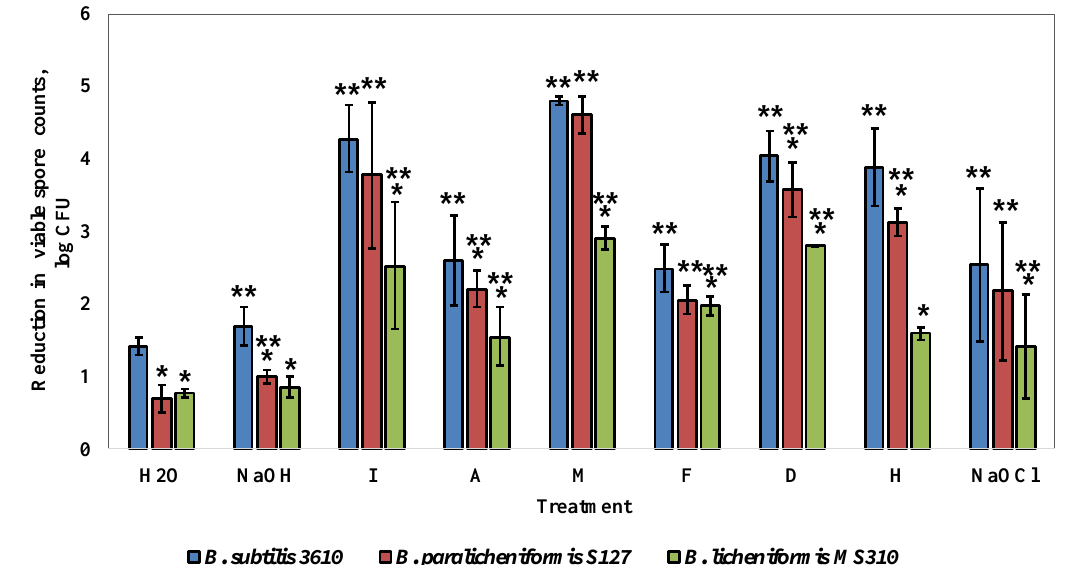
Figure 3. E ff ect of commercial cleaning agents on the removal of the biofilm-derived spores of the dairy-associated Bacillus in the simplified laboratory system. Sampling plates, each maintaining approximately 2 million spores of the tested Bacillus strains, were cleaned in the laboratory system. Caustic soda, sodium hypochlorite and the following cleaning solutions—I, A, M, F, D and H (compositions and dosages are described in Methods)—were used as the cleaning agents. The cleaning e ff ect was evaluated by comparing the numbers of viable spores (attached to sampling plates), before and after cleaning. The results represent the means and standard deviation (SD) of two independent biological experiments, performed in triplicate. * Statistically significant di ff erence ( p < 0.05) between the reduction in the viable spore counts in a given sample and the reduction in the spore counts for B. subtilis 3610 (control). ** Statistically significant di ff erence ( p < 0.05) between the reduction in the viable spore counts, after treatment with a given cleaning agent, and the reduction in the spore counts for the same strain, after incubation with tap